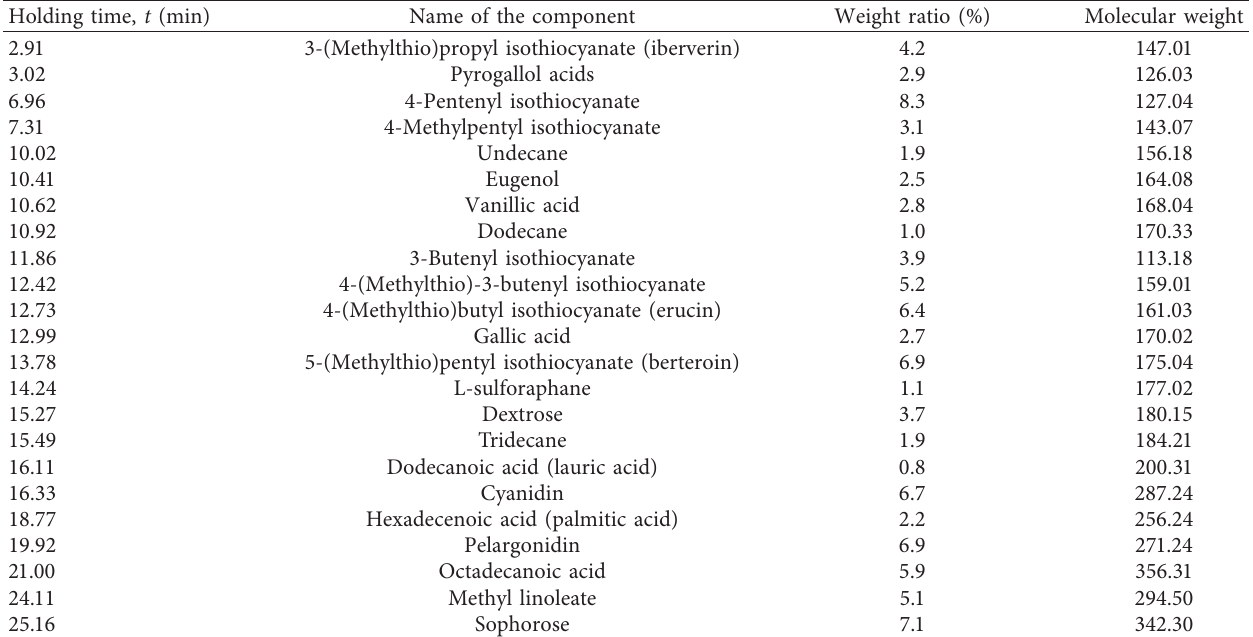
Figure 1: GC-MS spectra of the radish cake ethanol extract. Table 2: Composition of the radish cake extract according to GC-MS